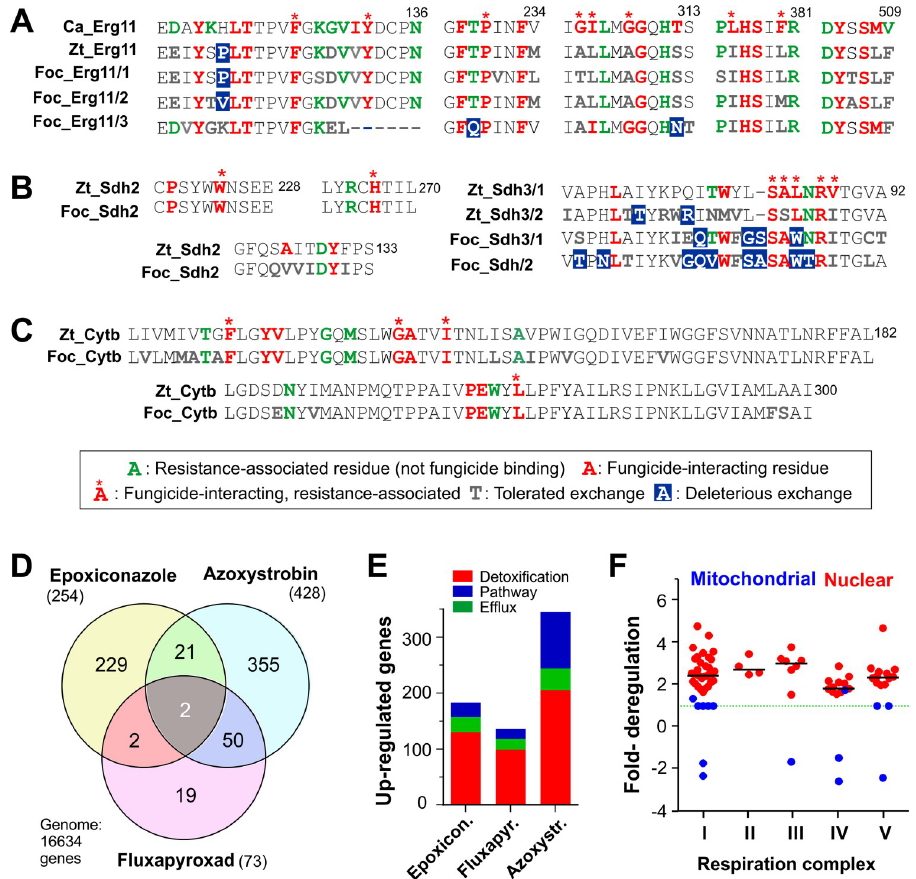
Fig 4. Fungicide binding sites in target enzymes and fungicide-induced transcriptional changes in FocTR4 persisters. A Azole binding site in Candida albicans Erg11 (Ca_ERG11, UniProt ID: P10613), Z . tritici Erg11 (Zt_Erg11, UniProt ID: F9XG32), FocTR4 Erg11_1 (Foc_Erg11_1; UniProt ID: X0JWG9), FocTR4 Erg11_2 (Foc_Erg11_2, UniProt ID: X0LR56) and FocTR4 Erg11_3 (Foc_Erg11_3, UniProt ID: X0JM02). Residues known in C . albicans Cyb51, reported to bind the azoles posaconazole and oteseconazole [41], are shown in red-bold; asterisk indicate potential involvement in resistance [35]; the impact of all residue substitutions in the Z . tritici and FocTR4 homologues of Ca_ERG11 was estimated using the SIFT server (https://sift.bii.a-star.edu.sg/); sequence alignment and determination of conserved amino acid exchanges used Clustal Omega (https://www.ebi.ac.uk/Tools/msa/clustalo/). B SDHI-binding site in succinate dehydrogenase subunits of Z . tritici (ZtSdh2, UniProt ID: O42772; ZtSdh4, UniProt ID: F9X9V6; ZtSdh3_1, UniProt ID: F9XH52; ZtSdh3_2, UniProt ID: F9XLX9 (partial); complete ZtSdh3_2 sequence at FungiDB, https://fungidb.org/fungidb/app/record/gene/ZTRI_10.476;) and FocTR4 (FocSdh2, UniProt ID: X0JUP8; FocSdh4, UniProt ID: X0JC07; FocSdh3_1, UniProt ID: X0JTM7; FocSdh3_2, UniProt ID: X0K132). Residues known in Z . tritici and other fungi to bind SDHI molecules [36] are shown in red-bold; asterisks indicate potential involvement in resistance [36]; the impact of all residue substitutions in FocTR4 homologues was estimated using the SIFT server (https://sift.bii.a-star.edu.sg/); sequence alignment used Clustal Omega (https://www.ebi.ac.uk/Tools/msa/ clustalo/). C Comparison of the amino acid sequence of quinol oxidation (Qo) site of mitochondrial cytochrome b in Z . tritici (ZtCytb; UniProt ID: Q6X9S4) and FocTR4 (FocCytb, UniProt ID: A0A1A7TD23). Residues known to bind strobilurin molecules are shown in red-bold; asterisks indicate potential involvement in resistance; the impact of all residue substitutions in FocTR4 was estimated using the SIFT server (https://sift.bii.a-star.edu.sg/); sequence alignment used Clustal Omega (https://www.ebi.ac.uk/Tools/msa/clustalo/). Note that all substitutions in FocCytb are predicted to be of low impact ("tolerated"). Information on strobilurin molecule-interacting (Cpd-interacting) and resistance- conferring residues from [33,34]. D Venn diagram showing numbers of FocTR4 genes, up-regulated significantly ( > 5-fold) in the presence of fungicides. Note that a transcription factor (UniProt ID: X0JJ38) and an ABC transporter (UniProt ID: X0JJA9) are up-regulated in all conditions. E Number of up-regulated genes in FocTR4 persister cells, putatively involved in providing fungicide tolerance. Putative detoxifying enzymes (red), efflux transporter and pumps (green) and proteins involved in the targeted cellular pathway (blue) that are significantly upregulated (P < 0.05) in epoxiconazole, fluxapyroxad and azoxystrobin-persisters are included. F Regulation of FocTR4 mitochondrial respiration complex subunits in the presence of 500 μ g ml -1 azoxystrobin. Dotted green line indicates non-significant difference to methanol-treated control cells. Median of expression of nucleus-encoded subunits (red) is indicated